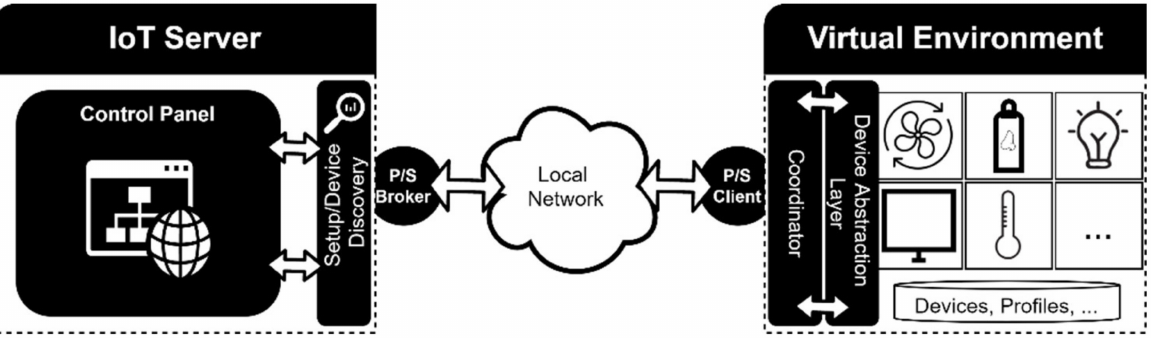
Figure 1. Architecture overview of the IoT mulsemedia environments prototyping software. It is composed of a control server and, at least, one virtual environment of “things”, managed by a virtual